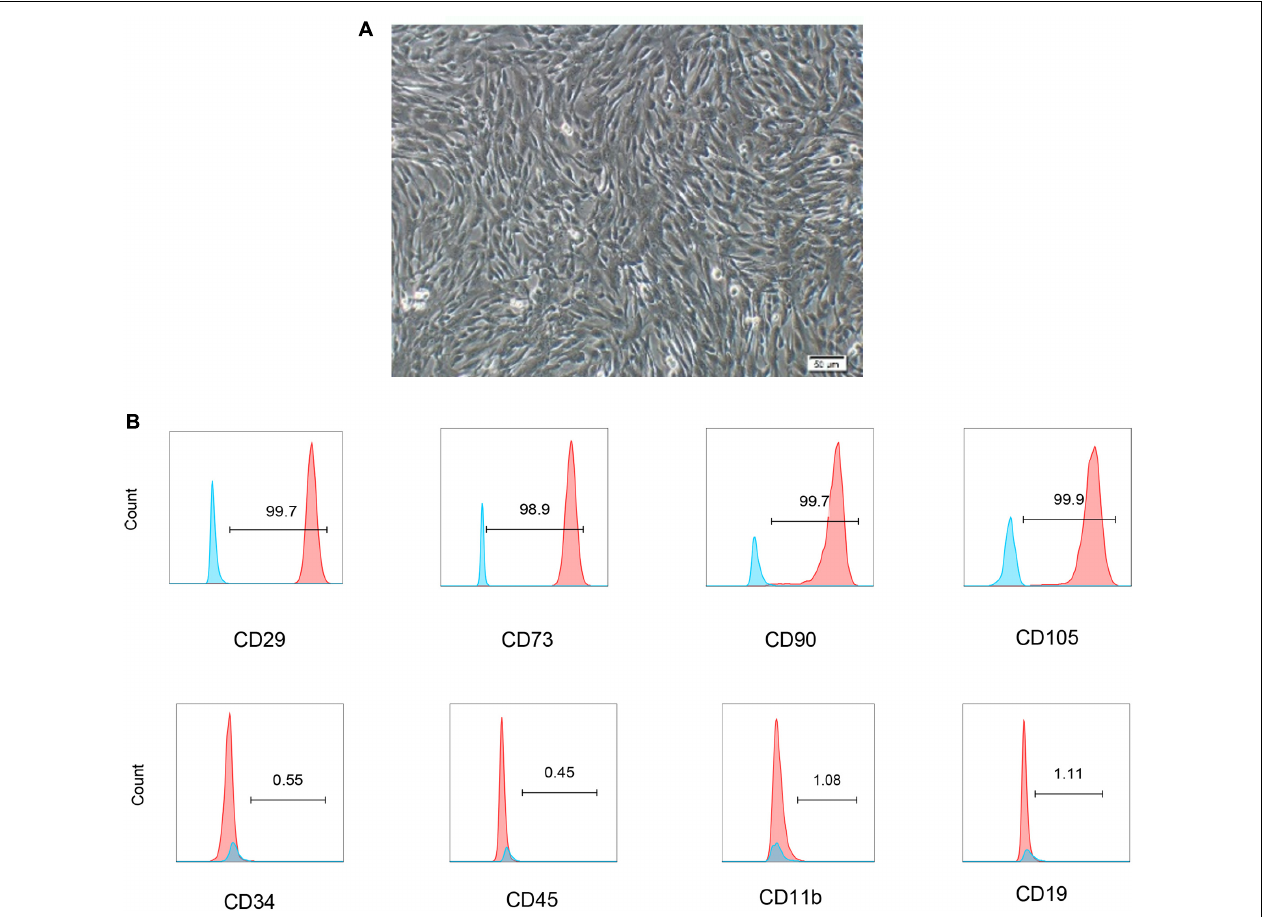
FIGURE 1 | Characterization of hUCB-MSCs. (A) Representative micrograph showing the typical cell morphology of hUCB-MSC colonies of proliferating fibroblast-like mesenchymal cells. (B) The phenotype of hUCB-MSCs and the percentage of cells with positive cell surface markers (blue line was negative staining control, red line was specific staining of indicated